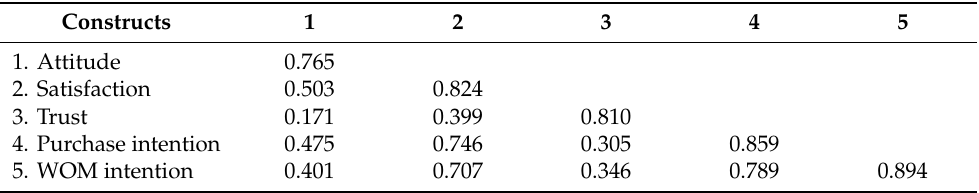
Table 4. Discriminant validity of the measurement model.